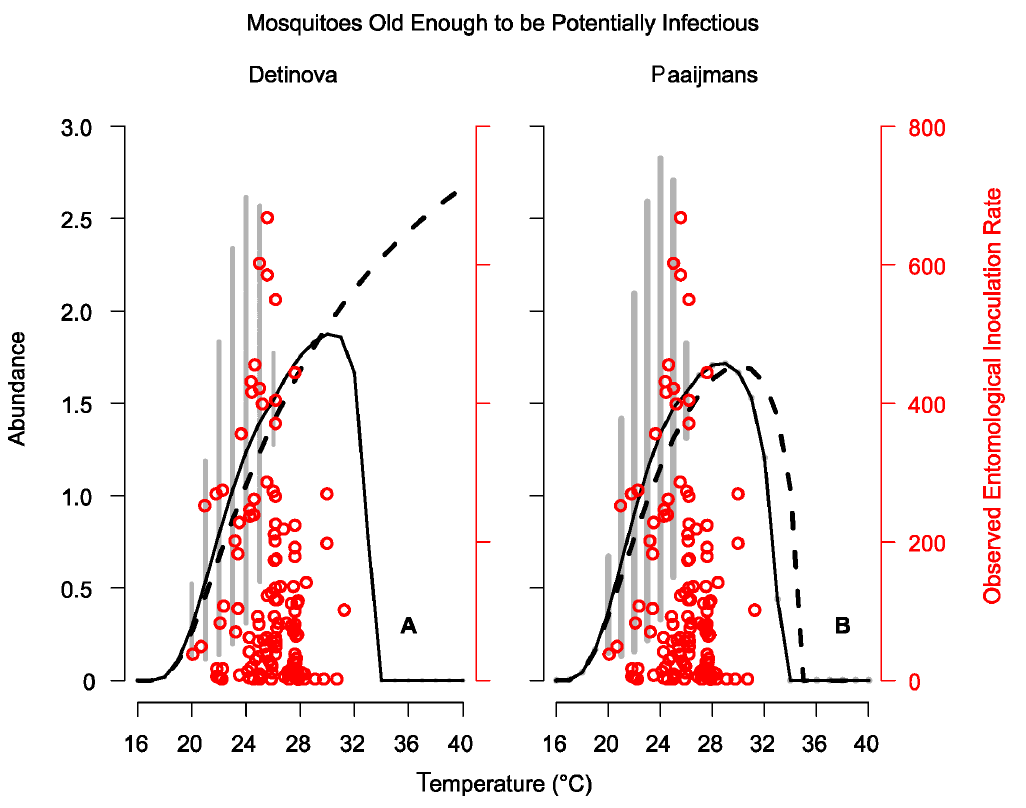
Figure 5. Potential for infectious mosquitoes. The abundance of mosquitoes old enough to be potentially infectious across temperatures. In both graphs the solid line represents the predictions made using our model in combination with either the Detinova (A) or Paaijmans (B) EIP prediction curve. The gray points and bars in both panels are the stable and cyclic abundances predicted by our model, respectively. The dashed lines represent the predictions made using the classic model assumptions of a constant vector population, in combination either the Detinova (A) or Paaijmans (B) EIP prediction curve. The red points, which correspond to the right y-axis are the observed entomological inoculation rates from 14 countries in Africa, compiled by [54].